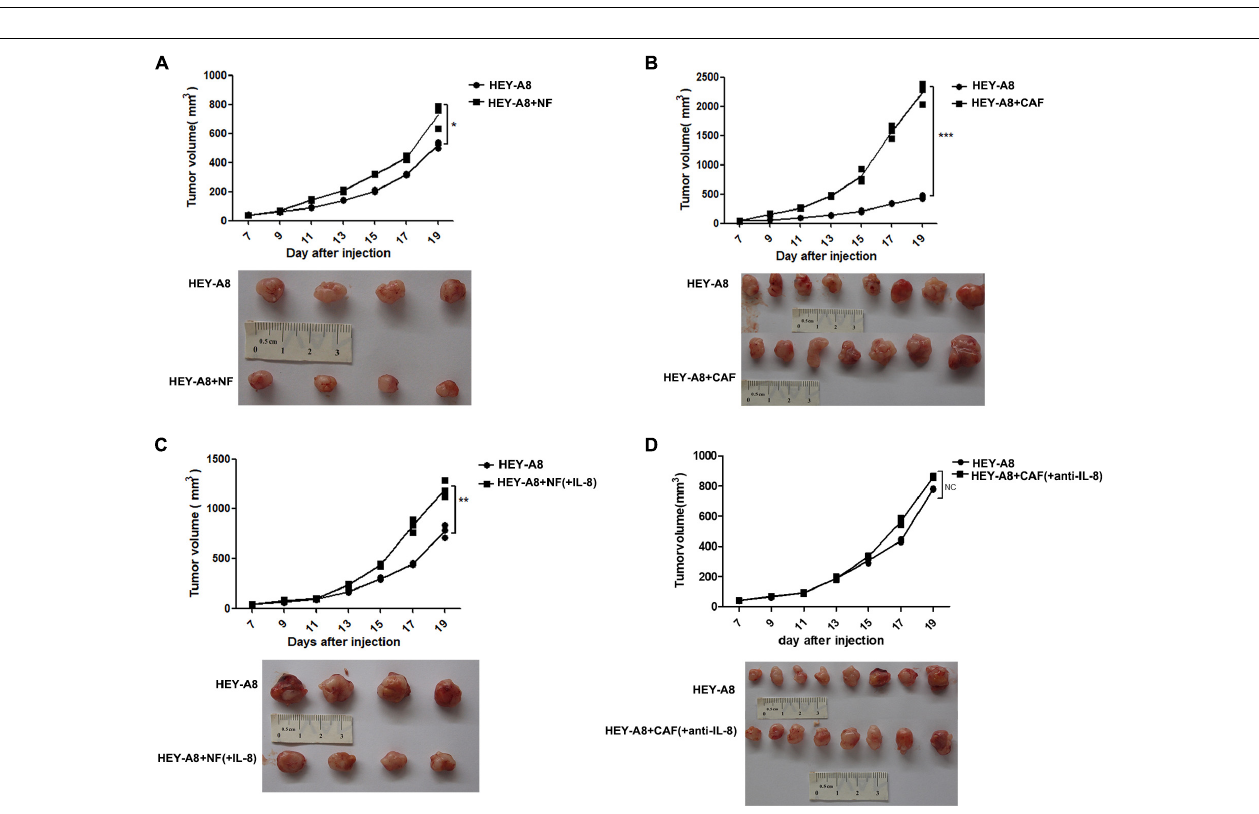
FIGURE 3 | IL-8 stimulates xenograft tumor growth in animals. Xenograft tumor growth by subcutaneous injection of HEY-A8 cells mixed with different fibroblast NFs (A) , CAFs (B) , NFs + IL-8 (C) , or CAFs neutralized by IL-8 antibody (D) as indicated. * p < 0.05, ** p < 0.01, *** p < 0.001. IL, interleukin; NFs, normal ovarian fibroblasts; CAFs, cancer-associated